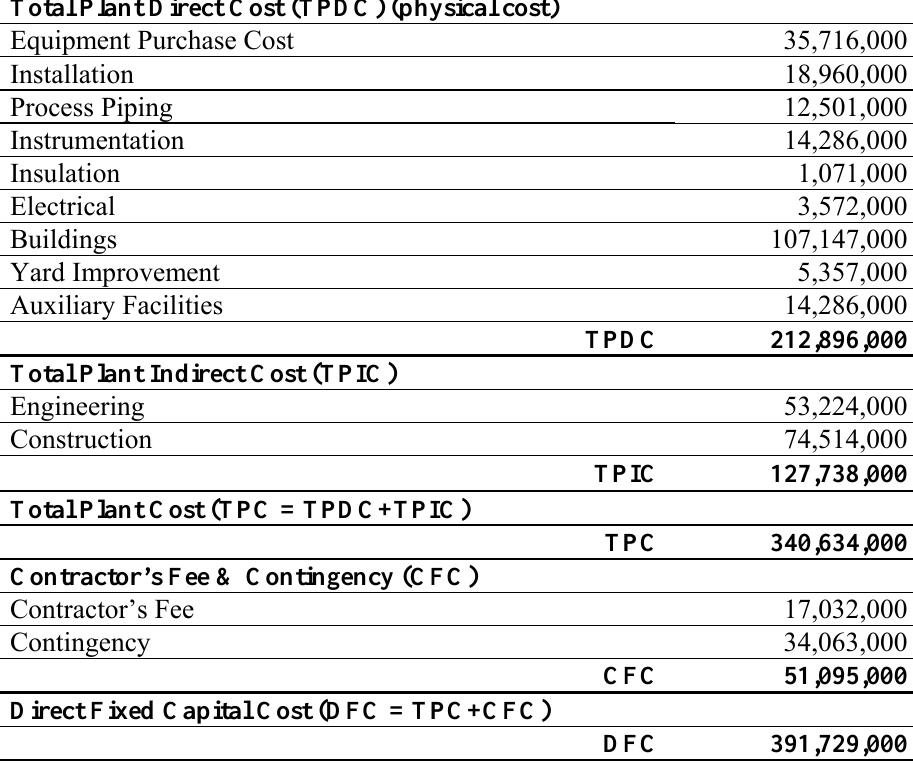
Table 3. Fixed Capital Estimate Summary (Year 2013 prices in US $).